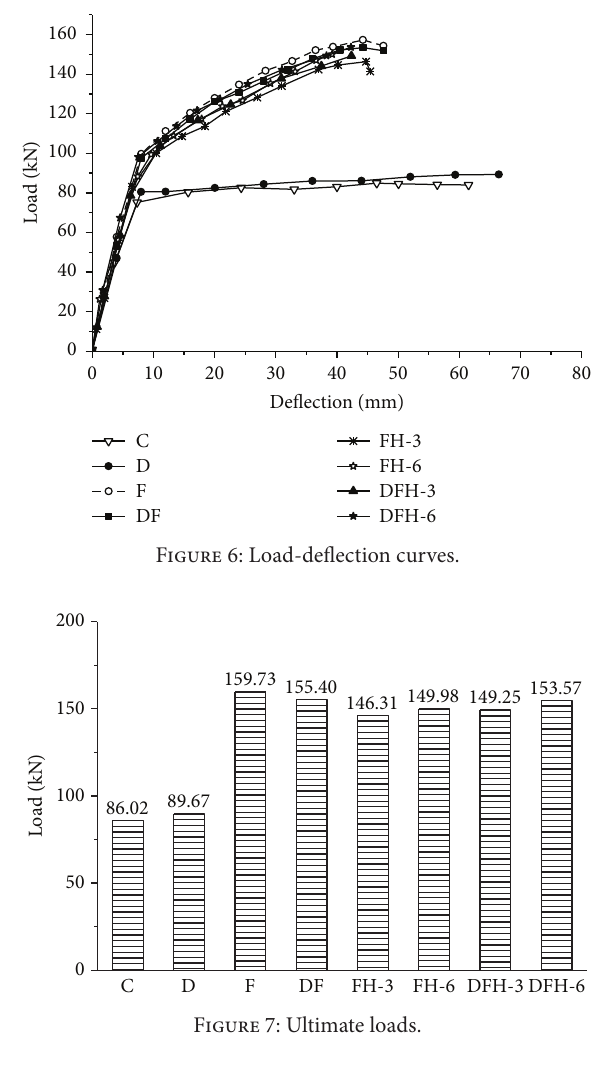
Figure 7: Ultimate loads.